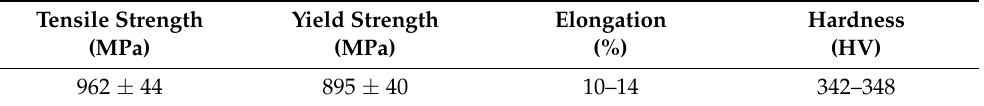
Table 1. Mechanical properties of work material (Ti-6Al-4V).